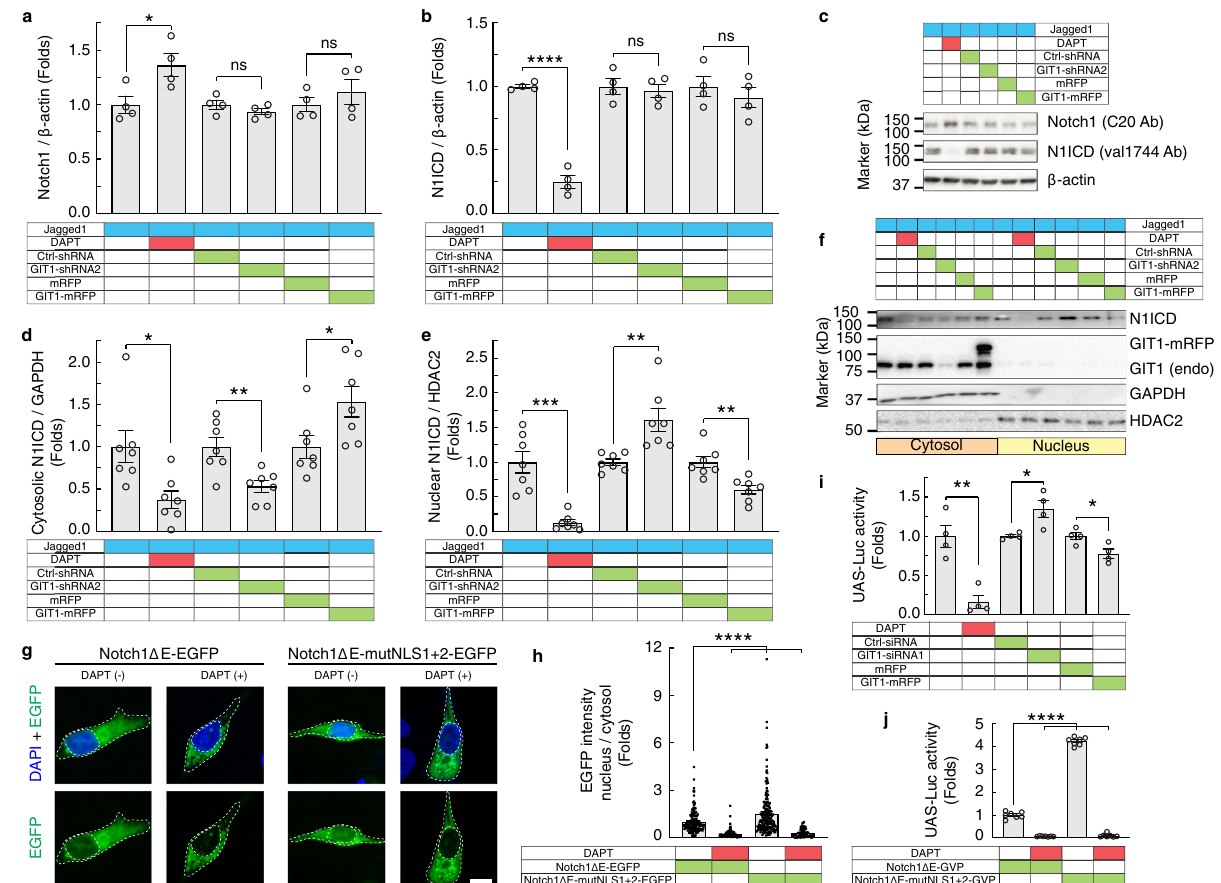
Fig. 4 GIT1 regulates the subcellular distribution of the Notch ICD. a – c Quantitative analyses of Notch1 ( a ; n = 4, vehicle versus DAPT, P = 0.032; Ctrl- shRNA versus GIT1-shRNA2, P = 0.26; mRFP versus GIT1-mRFP, P = 0.40; t tests) and the Notch1 ICD (N1ICD) ( b ; n = 4, vehicle versus DAPT, P < 0.0001; Ctrl-shRNA versus GIT1-shRNA2, P = 0.67; mRFP versus GIT1-mRFP, P = 0.46; t tests) western blots ( c ) from lysates of MDA-MB-231 cells treated as indicated. d – f Quantitative analyses of cytosolic ( d ; n = 7, vehicle versus DAPT, P = 0.013; Ctrl-shRNA versus GIT1-shRNA2, P = 0.0045; mRFP versus GIT1-mRFP, P = 0.035; t tests) and nuclear ( e ; n = 7, vehicle versus DAPT, P = 0.0001; Ctrl-shRNA versus GIT1-shRNA2, P = 0.0042; mRFP versus GIT1- mRFP, P = 0.0025; t tests) subcellular fractionation assays with western blots ( f ) from MDA-MB-231 cells treated as indicated. g , h Confocal images ( g ) and quantitative analysis of EGFP intensities in the cytoplasm and nucleus ( h ; Notch1 Δ E − EGFP ( n = 150 cells) versus: Notch1 Δ E − EGFP + DAPT ( n = 79 cells), P < 0.0001; Notch1 Δ E-mutNLS1 + 2 − EGFP ( n = 180 cells), P < 0.0001; Notch1 Δ E-mutNLS1 + 2 − EGFP + DAPT ( n = 63 cells), P < 0.0001; one-way ANOVA, F 3,468 = 42.82, P < 0.0001) of MDA-MB-231 cells treated as indicated. Nuclei were detected using DAPI. i , j Luciferase reporter assays of Notch1 ICD (UAS-Luc) in MDA-MB-231 cells with knockdown or overexpression of GIT1 ( i ; n = 4, vehicle versus DAPT, P = 0.0019; Ctrl-siRNA versus GIT1-siRNA1, P = 0.020; mRFP versus GIT1-mRFP, P = 0.027; t tests) or mutated NLS1 and NLS2 ( j ; n = 7, Notch1 Δ E-GVP versus: Notch1 Δ E-GVP + DAPT, P < 0.0001; Notch1 Δ E-mutNLS1 + 2-GVP, P < 0.0001; Notch1 Δ E-mutNLS1 + 2-GVP + DAPT, P < 0.0001; one-way ANOVA, F = 1828, P < 0.0001). Scale 3,24 bar, 10 μ m. All data are shown as the mean ± s.e.m. n denotes the number of biologically independent replicates, unless stated otherwise. * P < 0.05, ** P < 0.01, *** P < 0.001, **** P < 0.0001, ns, not signi fi cant by two-sided unpaired t tests or one-way ANOVA with Tukey ’ s post hoc comparison. Source data are provided as a Source Data fi affect S3 cleavage of Notch. The synthesis and degradation of Notch1 were also unaffected by modifying the expression level of GIT1 (Supplementary Fig. 10). In contrast, the intracellular distribution of the Notch1 ICD was altered by GIT1. Knockdown of GIT1 increased the amount of the Notch1 ICD in the nuclear fraction and was accompanied by a corresponding decrease in the cytosolic fraction (Fig. 4d, f; n = 7, Ctrl-shRNA versus GIT1-shRNA2, P = 0.0045; mRFP versus GIT1-mRFP, P = 0.035; t tests). Conversely, the over- expression of GIT1 resulted in a decrease in the nuclear Notch1 ICD level, with a concomitant increase in the cytosolic fraction (Fig. 4e, f; n = 7, Ctrl-shRNA versus GIT1-shRNA2, P = 0.0042; mRFP versus GIT1-mRFP, P = 0.0025; t tests). Next, we analysed the intracellular distribution of the control Notch1 ICD and the Notch1 ICD with mutated NLS1 and NLS2 generated by